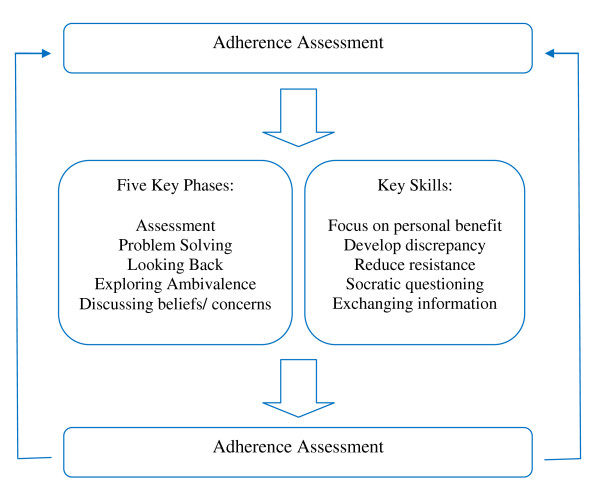
CAAT-PARK model.